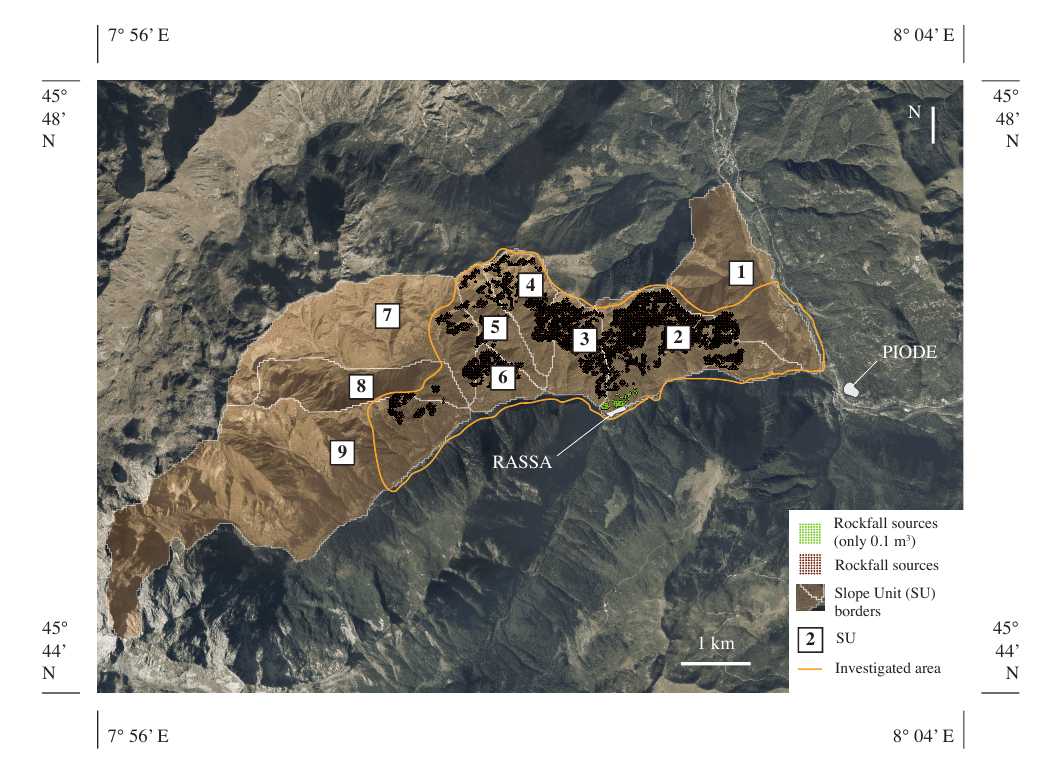
Figure 3. Rockfall source distribution along slope